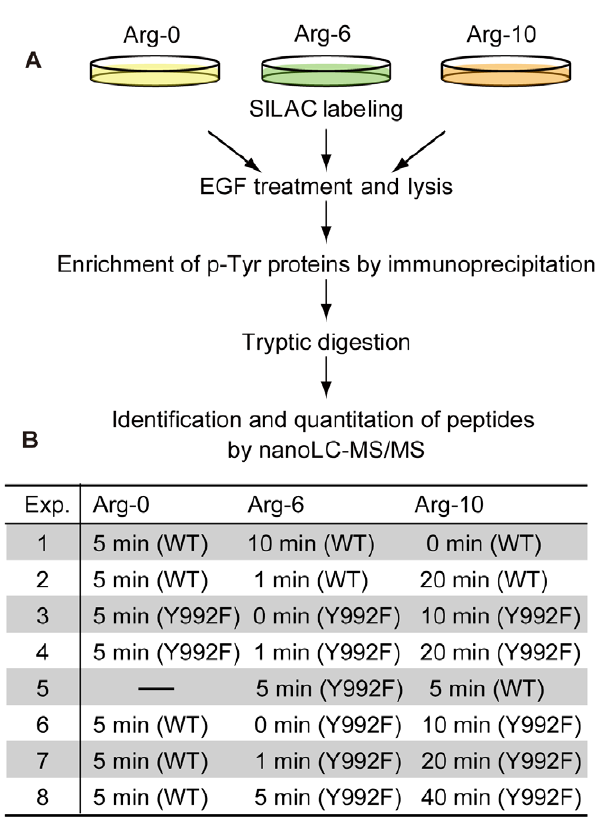
Figure 1. Strategy for measuring the quantitative behaviors of EGF-induced tyrosine phosphoproteome in WT and Y992F cells. A . Flowchart for SILAC experiment. Each cell population encoded with isotopically labeled arginine (Arg-0, Arg-6, or Arg-10) is stimulated with EGF for the time intervals indicated. Tyrosine phosphoproteins are enriched from equally mixed cell lysates using phospho-tyrosine specific antibodies. The purified complexes were digested in solution and directly applied to nano-flow LC-MS/MS system for protein identification and quantitation. B . An experimental design for acquiring temporal profiles of tyrosine phosphoproteome upon EGF stimulation. Temporal profiles were generated through integration of eight independent mass spectrometric measurements. For each time period, relative quantitative values were normalized to the values for WT at 5